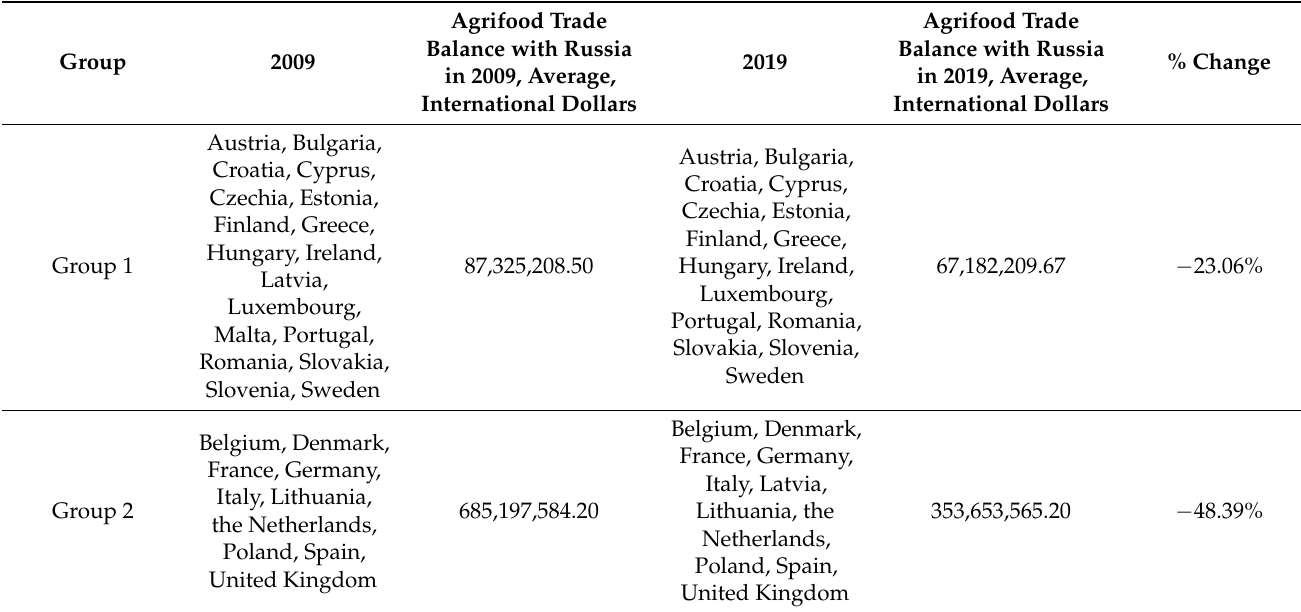
Table 2. Grouping of the EU28 countries according to the agri-food trade balance in 2009 and 2019.